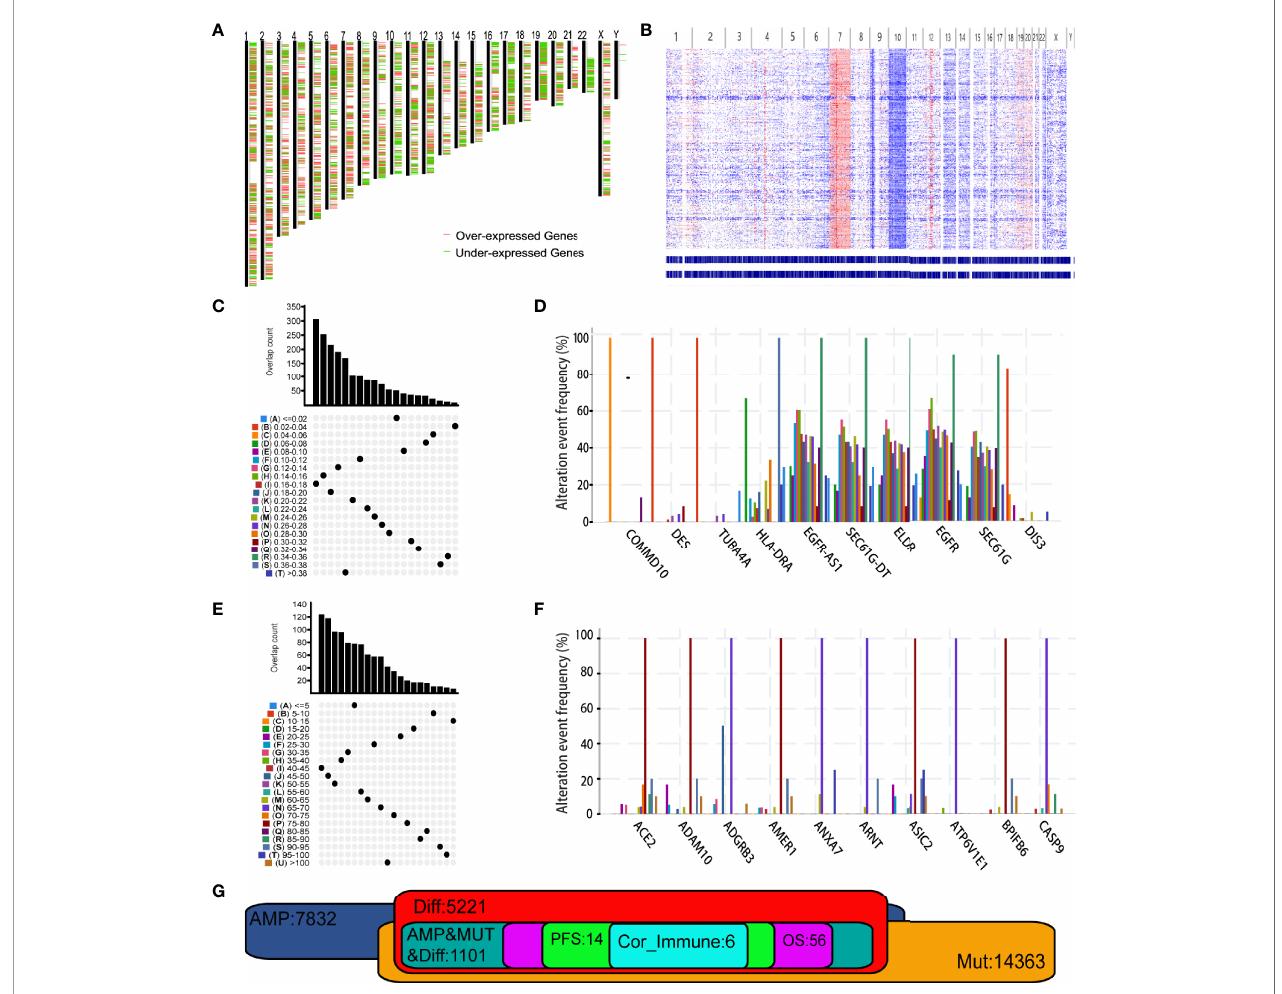
FIGURE 1 | Identi fi cation of potential tumor antigens of Glioblastoma multiforme (GBM). (A) Chromosomal distribution of up- and down-regulated genes in GBMs. Red plot: overexpressed genes; Green plot: under-expressed genes. (B) The chromosomal distribution of the aberrant copy number genes in GBMs. Red plot: ampli fi ed genes; Blue plot: deleted genes. (C) Samples overlapping in altered genome fraction groups. (D) Top ten genes with highest frequency in altered genome fraction. (E) Samples overlapping in mutation count groups. (F) Top ten genes with highest frequency in mutation count groups. (G) Potential tumor antigens (total 1106) with overexpression, mutation, and ampli fi cation in GBM, and signi fi cant association with OS, RFS and immune in fi ltration (total 6